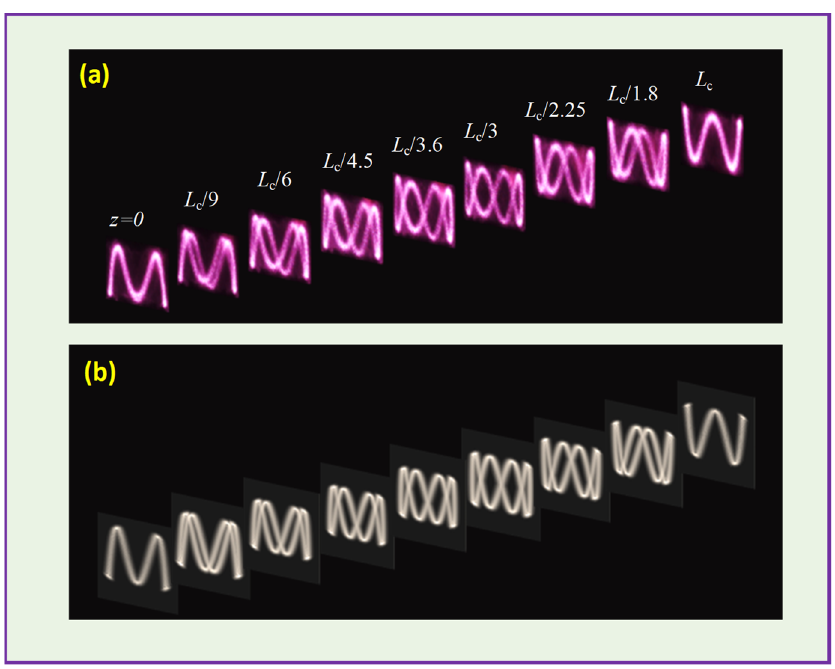
Figure 11. Lissajous geometric mode corresponding to the parameters of ( P , Q ) = ( 1, 3 ) , ( p , q ) = ( 4, − 1 ) , and φ x = φ y = π /3 for the transverse patterns at different positions: ( a ) experimental observations; ( b ) theoretical results.